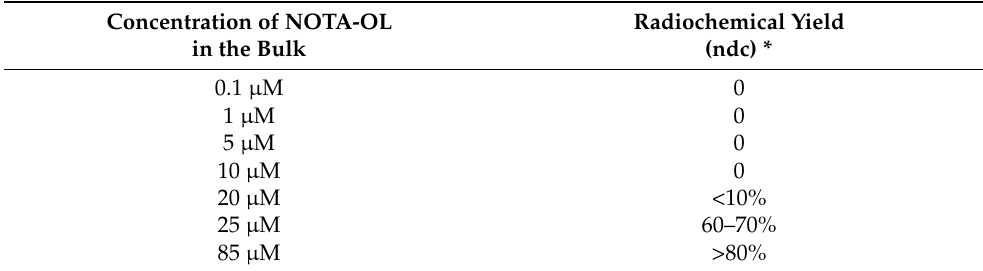
Table 1. Radiochemical yield (determined by radio-HPLC analysis of the crude product) of NOTA-OL labelling reaction with Gallium-68 at different concentrations of the substrate. Concentration of NOTA-OL